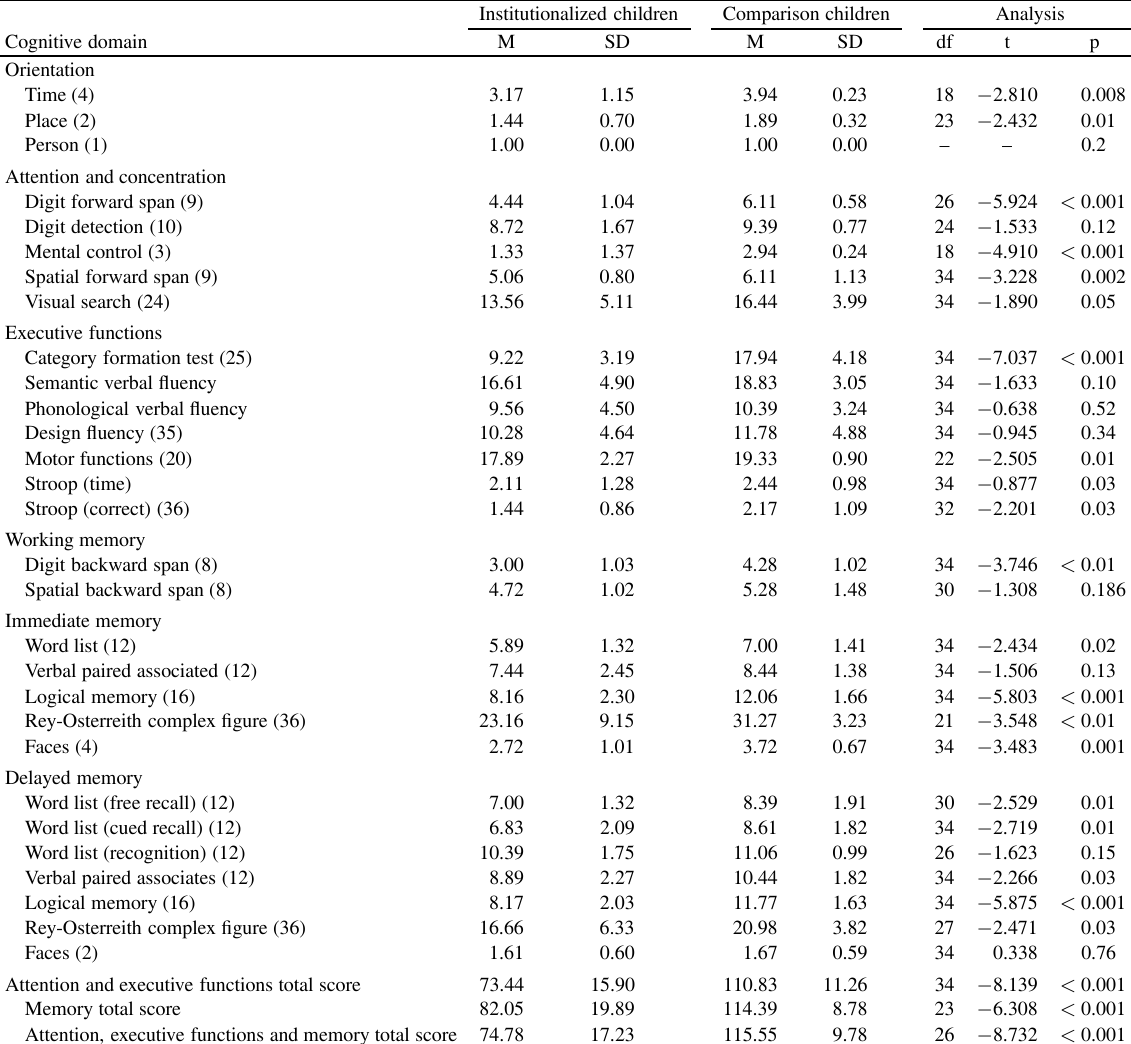
Table 2 Neuropsychological test scores of institutionalized children and comparison group Institutionalized children Comparison children